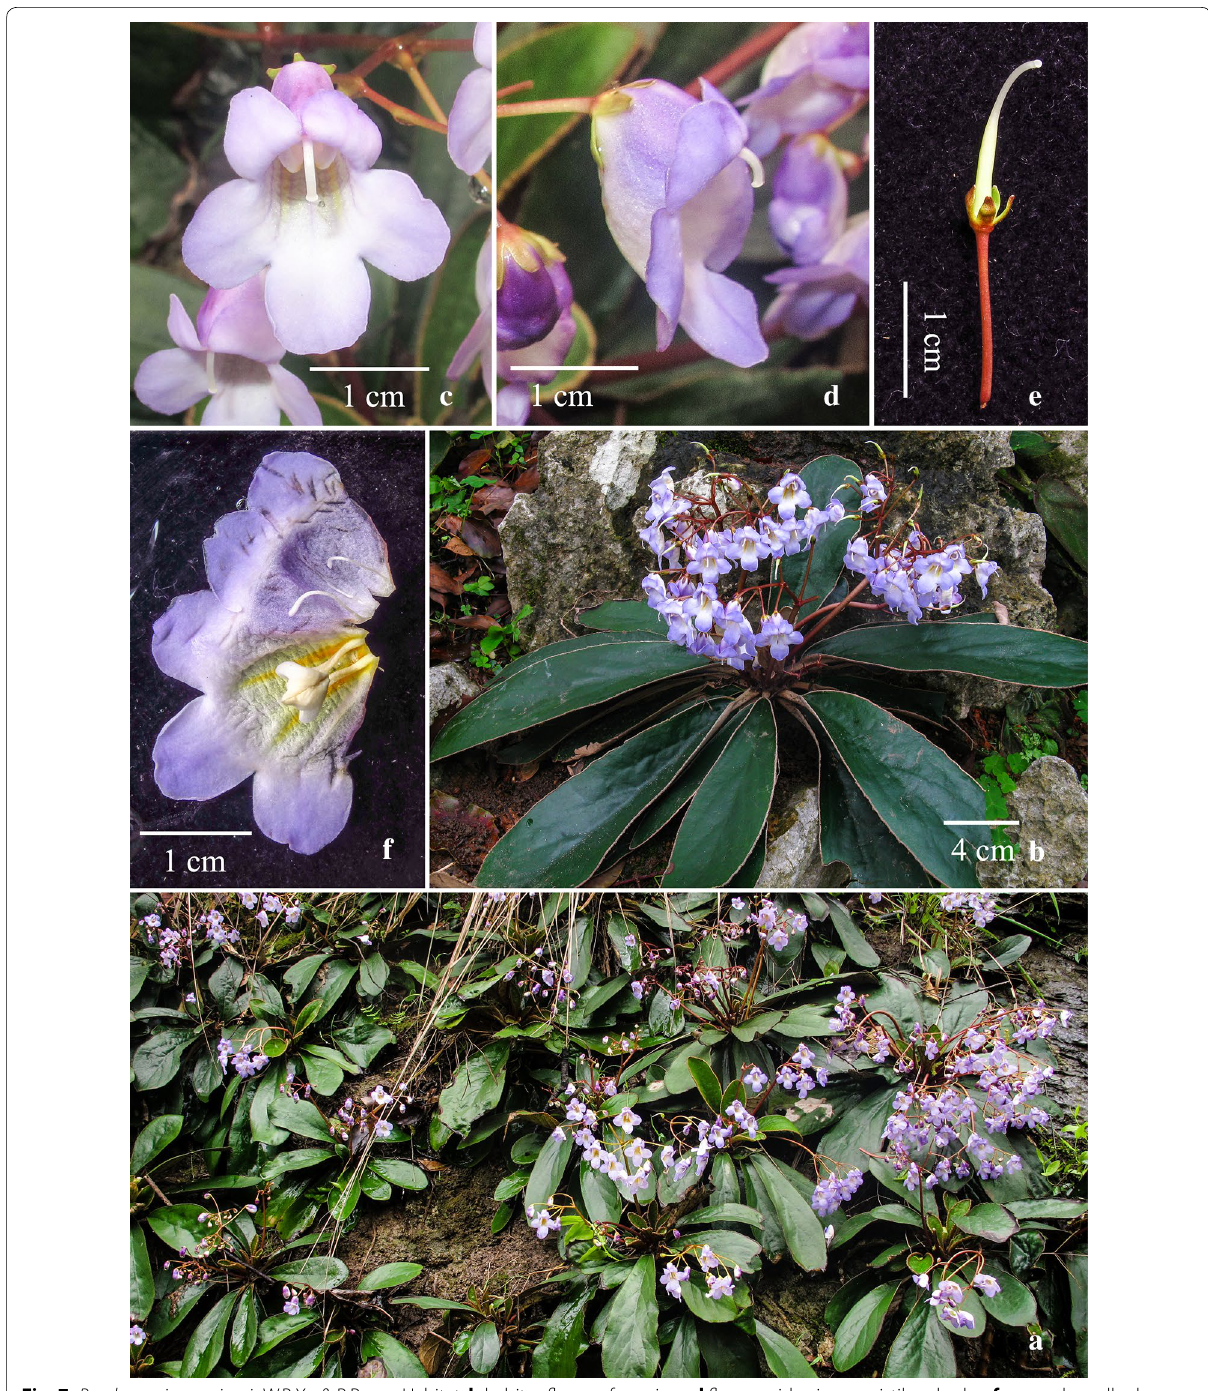
Fig. 7 Paraboea xiangguiensis W.B.Xu & B.Pan. a Habitat; b habit; c flowers face view; d flowers side view; e pistil and calyx; f opened corolla show‑ ing stamens and